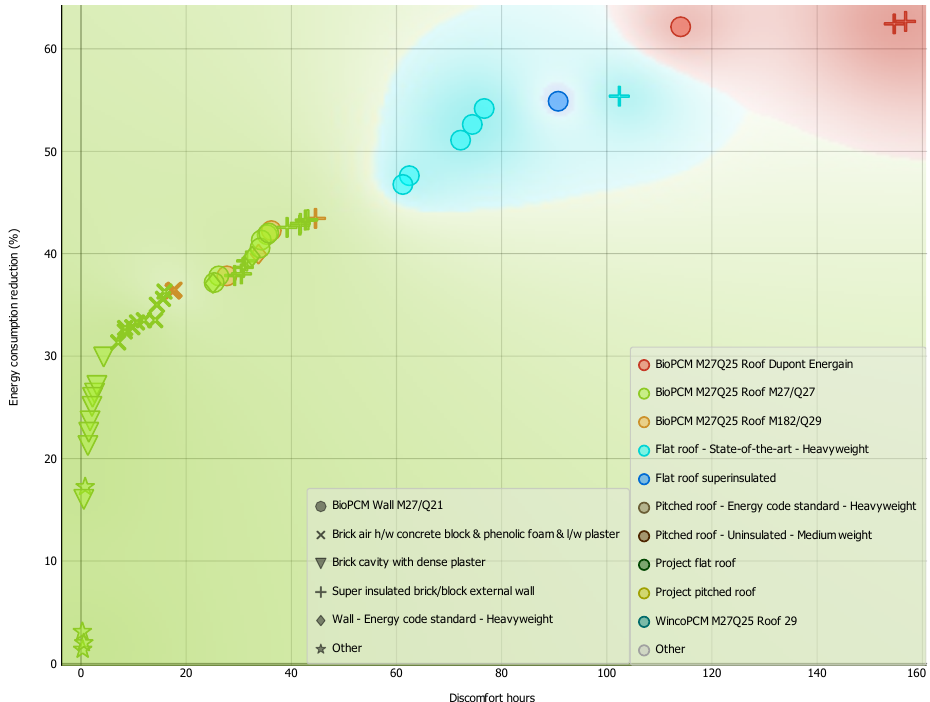
Figure 11. Results of energy consumption reduction (%) for cooling at Pareto’s front for the